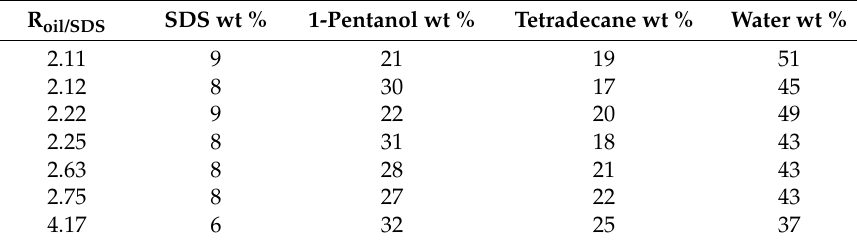
Table 1. Compositions of the investigated oil in water